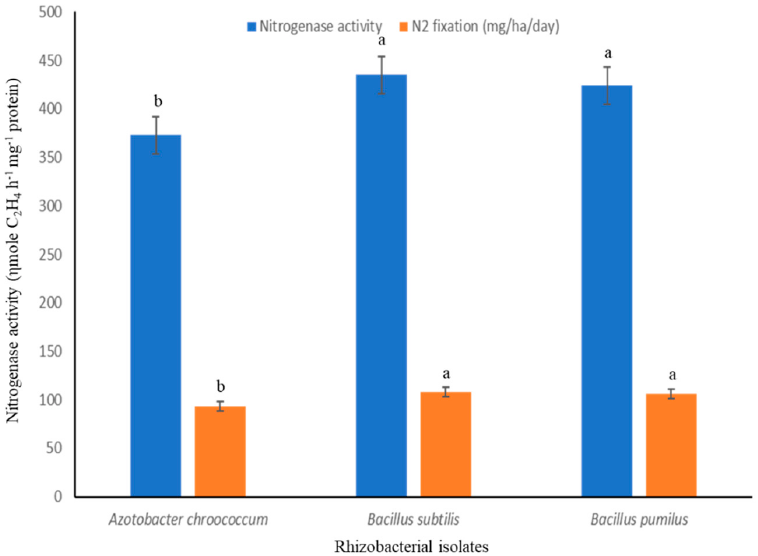
Figure 2. Nitrogenase activity of the PGPR’s isolates over reference strain. Different letters mean significant differences among categories ( p < 0.05). Error bars indicate ± SD.